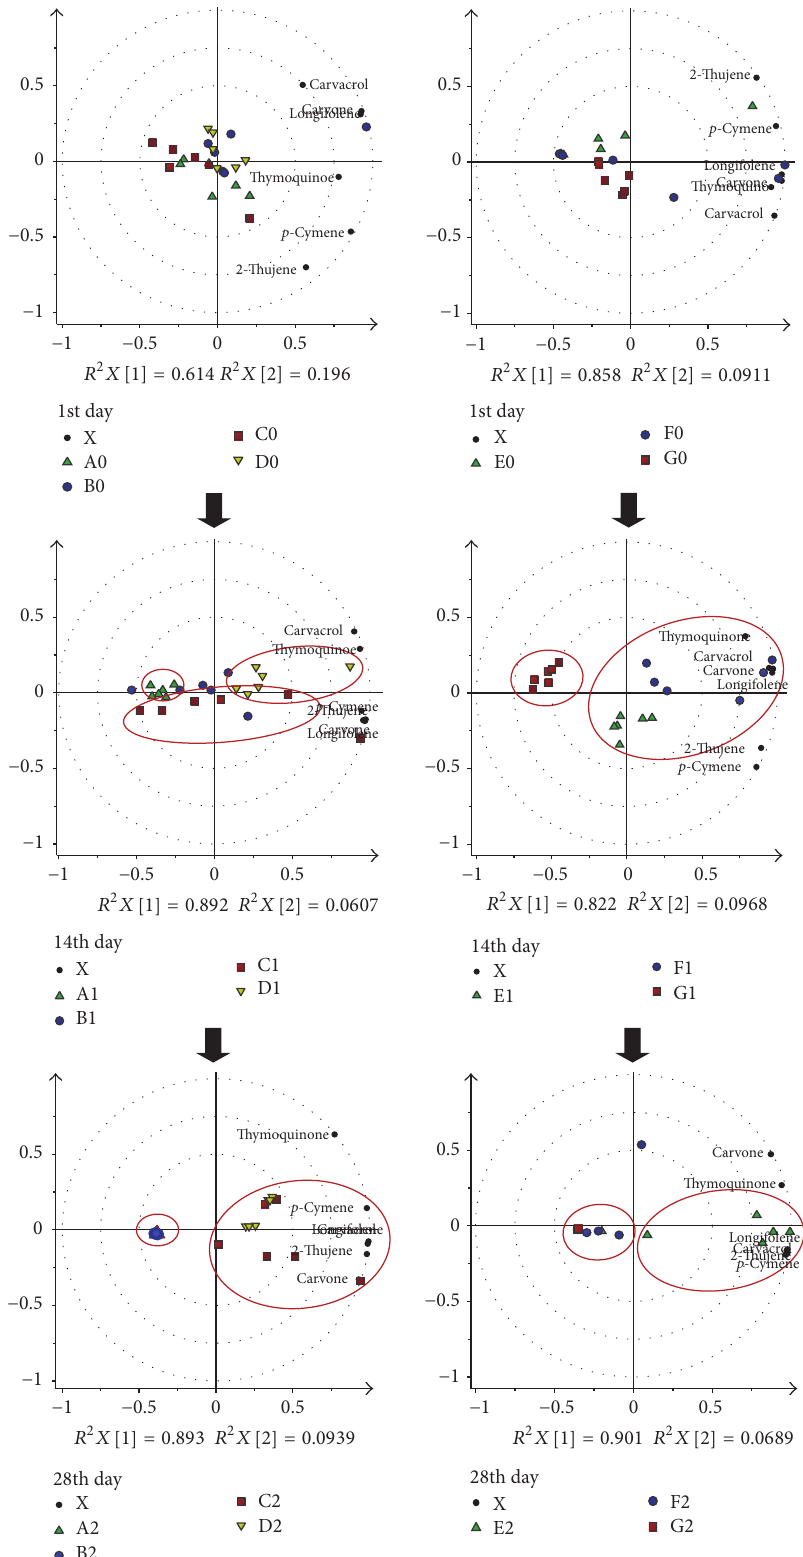
Figure 5: The biplot model of the principle component analysis (PCA) for the comparison of condition A (green triangle), B (blue circle), C (redsquare),andD(yellowtriangle)forwholeseeds(left)andconditionE(greentriangle),F(bluecircle),andG(redsquare)forgroundseeds (right) along the storage period. The blue circle refers to the time point of 14th (2). The smaller black circles are those identified compounds from the